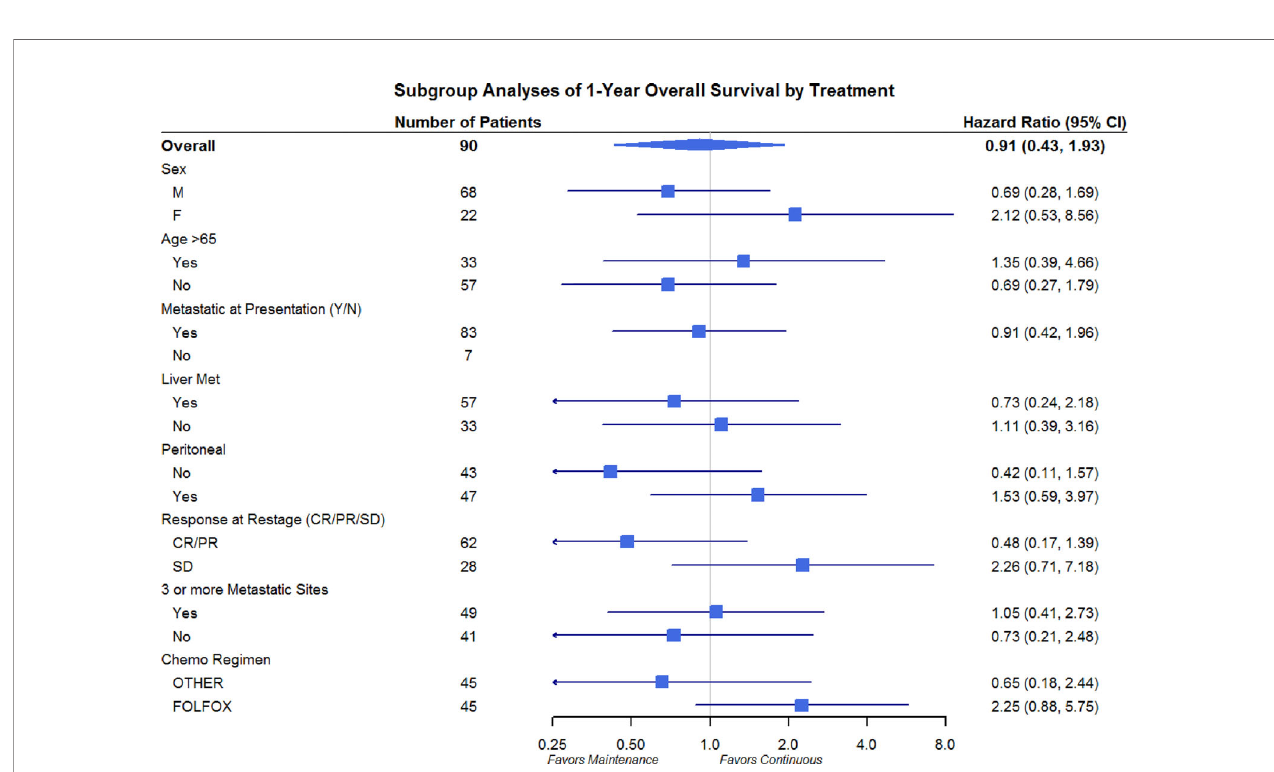
FIGURE 5 | Overall Survival Subgroup Analysis of at 1 year: Gender, Age, Metastatic Site, and Chemo